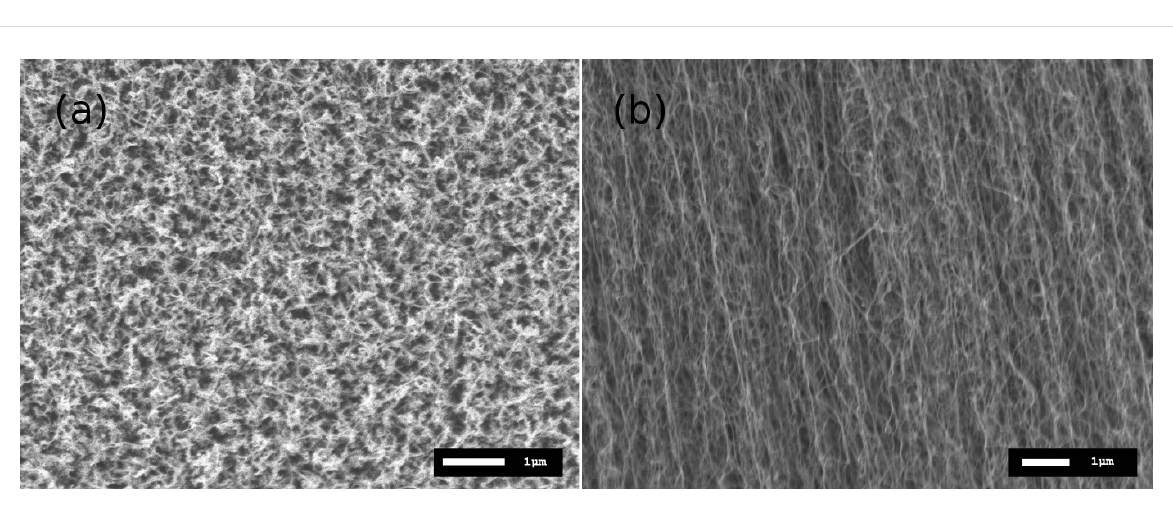
After the dispersion of the VA-CNTs in ethanol, a drop of the solution was deposited onto a commercial lacey-carbon grid which is well-visible in Figure 5a. Despite the dispersion of CNTs for the characterization, some VA-CNTs are still aggre- gated as exemplified in Figure 5a. The gold nanoparticles can